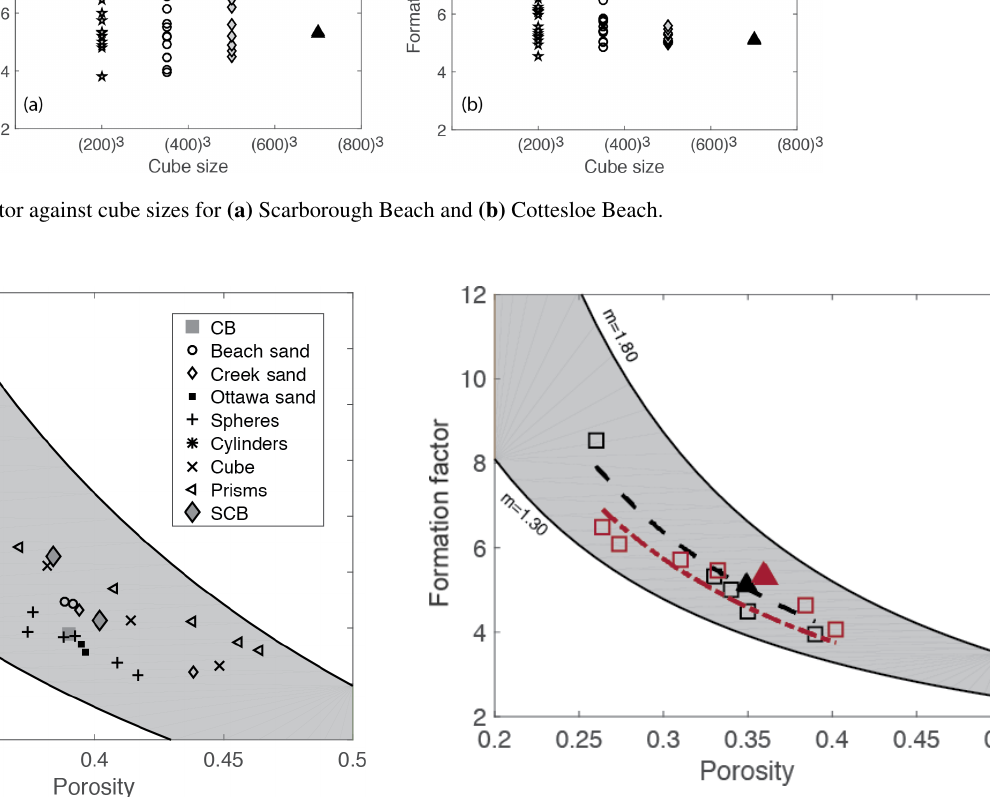
Figure 14. Comparison of laboratory results with results from other researchers (Wyllie and Gregory, 1953). CB stands for Cottesloe Beach samples, and SCB is for Scarborough Beach samples.